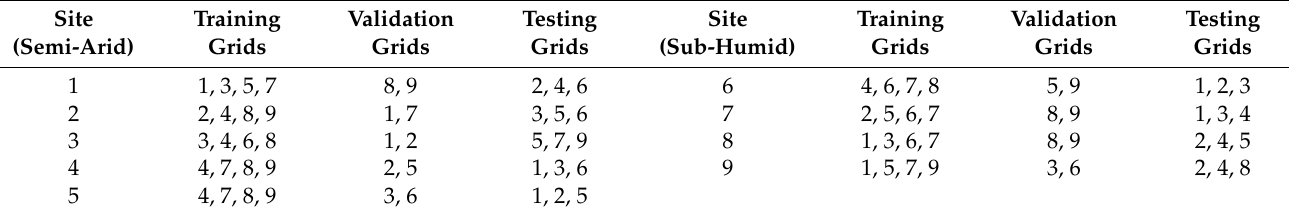
Table 3. Index of training, validation, and testing grids in each site.